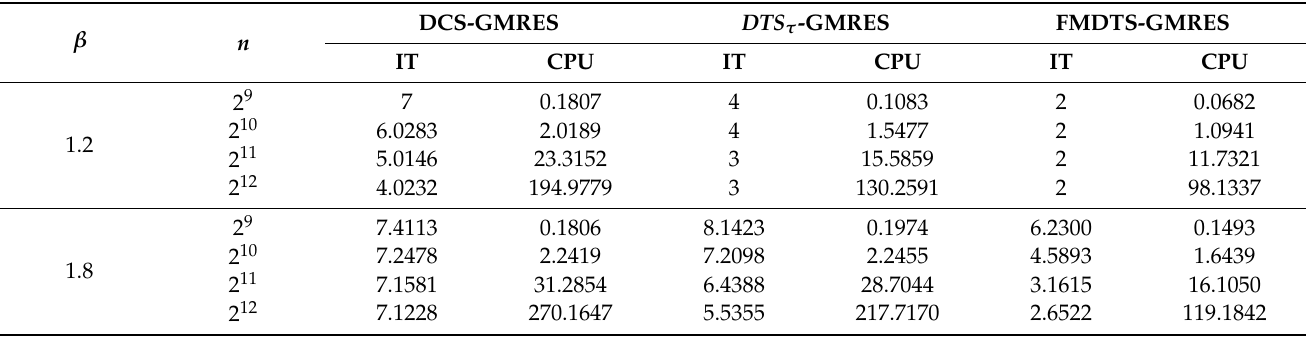
Table 1. Numerical results for solving Example